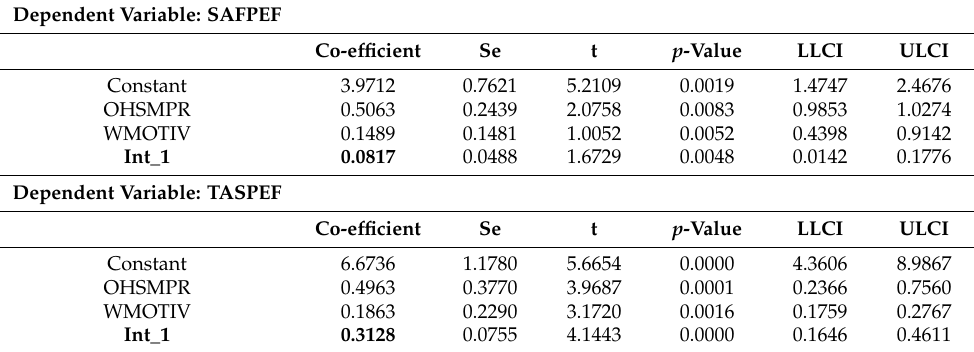
Table 10. Moderating